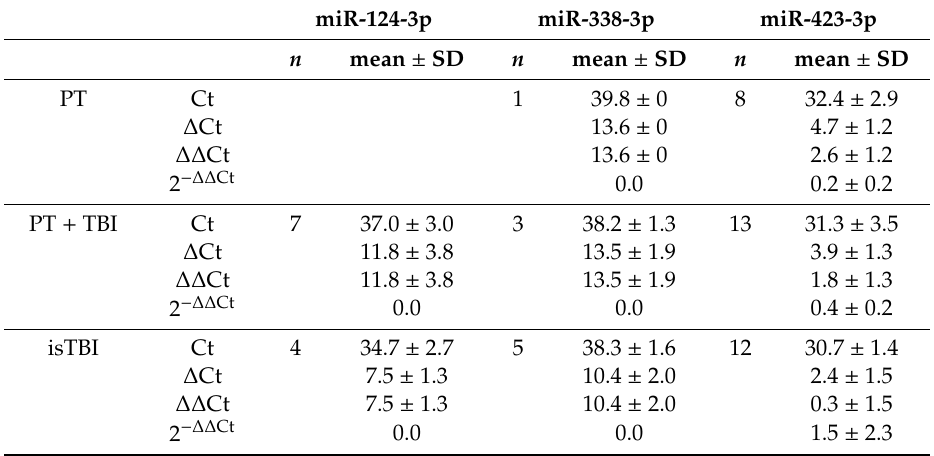
Table 2. Quantitative analysis of miR expression in trauma patients stratified by injury pattern.